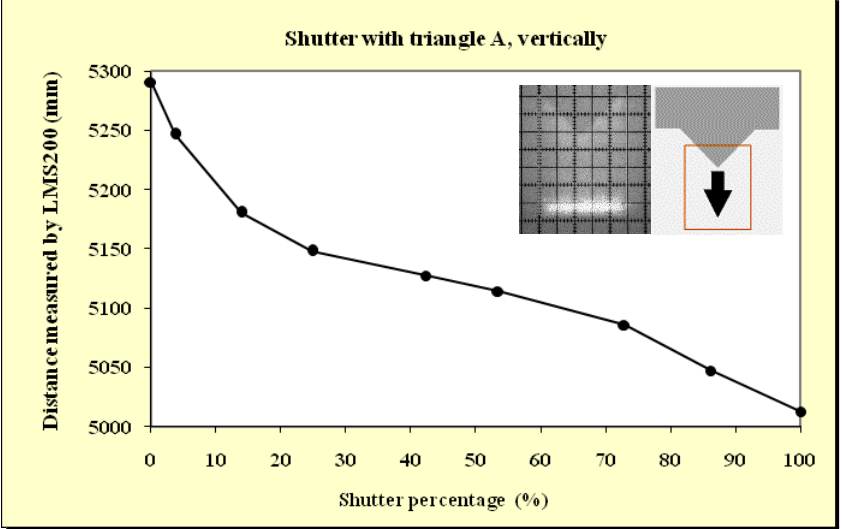
Figure 11. Graphic representation of the evolution of the distance measurement given by the sensor when the laser beam (90°) was incrementally blocked (from top to bottom) using the triangular shaped template A at a distance of 5 m from the sensor and the unblocked part of the beam was captured by the grid template at a distance of 5.3 m.